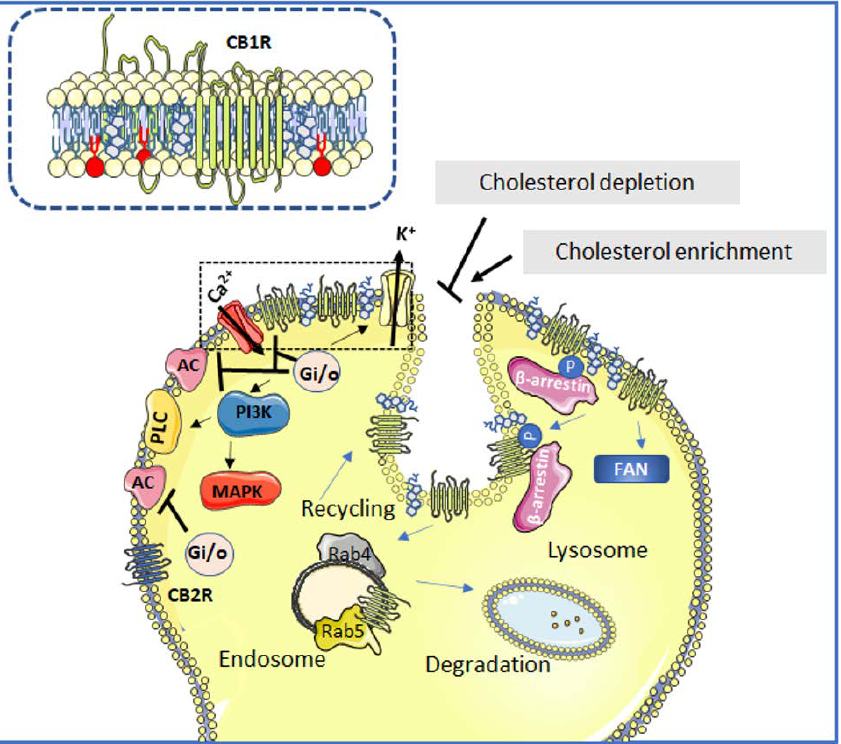
Figure 2. Schematic depiction of the interactions between cannabinoid receptor signaling and lipid domains. Neuromodulation upon agonist binding to CB1Rs and CB2Rs (unphosphorylated receptors) induces Gi/o-dependent inhibition of adenylyl cyclase (AC) activity and activation of different MAPK cascades. CB1R positively regulates inwardly rectifying K + channels, whereas it negatively regulates voltage-gated Ca 2+ channels. In addition, the CB1R can activate PLC at the plasma membrane and can also signal through non-G proteins such as the adaptor protein FAN. The phosphorylated CB1R is a target of β -arrestin. The attenuation of CB1R signaling at cholesterol-rich lipid domains occurs through a Rab5-dependent endocytic mechanism. Once internalized, the CB1R may either be recycled back to the plasma membrane through a Rab4-dependent mechanism or further targeted to lysosomal degradation. The CB2R does not reside in or interact with Lo lipid platforms. Alteration of ordered lipid domain integrity either by depleting or supplying cholesterol is shown to inhibit or enhance the internalization of CB1R, respectively. The inset depicts a closer view of the cholesterol-rich Lo lipid domain (marked with a dotted line in the main figure). Cholesterol molecule in gray, sphingolipids in red and other phospholipids in